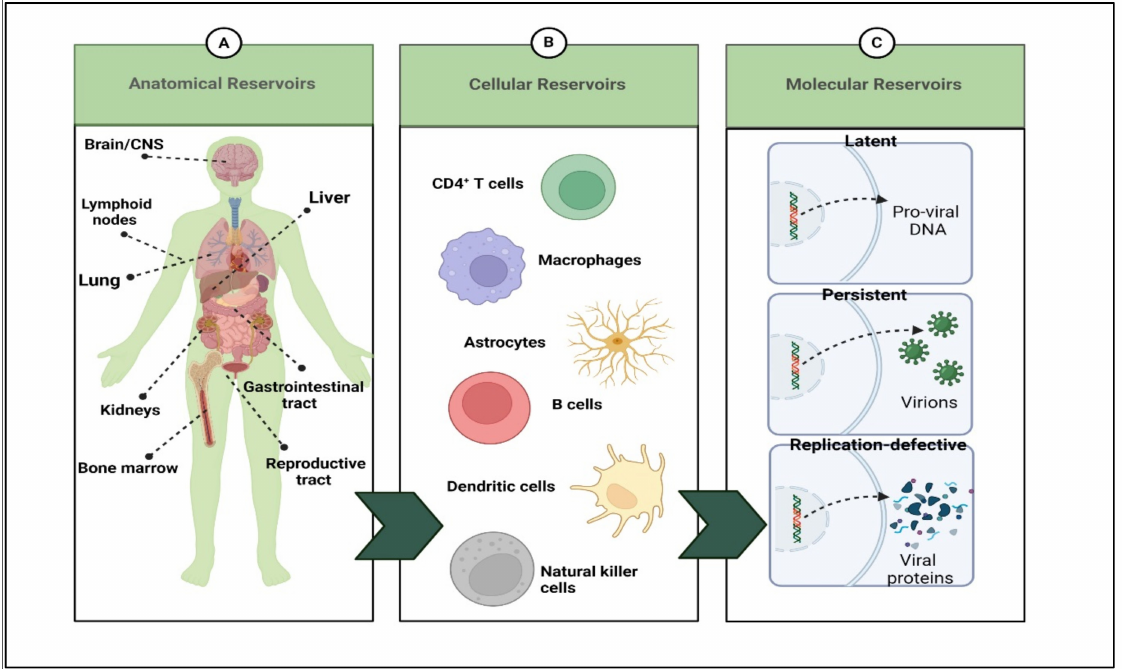
Figure 3. Summary HIV reservoirs. There are several anatomical compartments ( A ) that are pop- ulated by HIV-infected cells ( B ). ( C ) The integrated provirus contained within these cells may be transcriptionally silent (latent), transcriptionally active and capable of producing infectious virions (persistent), or transcriptionally active but replication defective due to mutations or deletions in the HIV genome, leading to translation of specific viral proteins for which an open reading frame remains intact. (Created with BioRender.com (access on 19 June